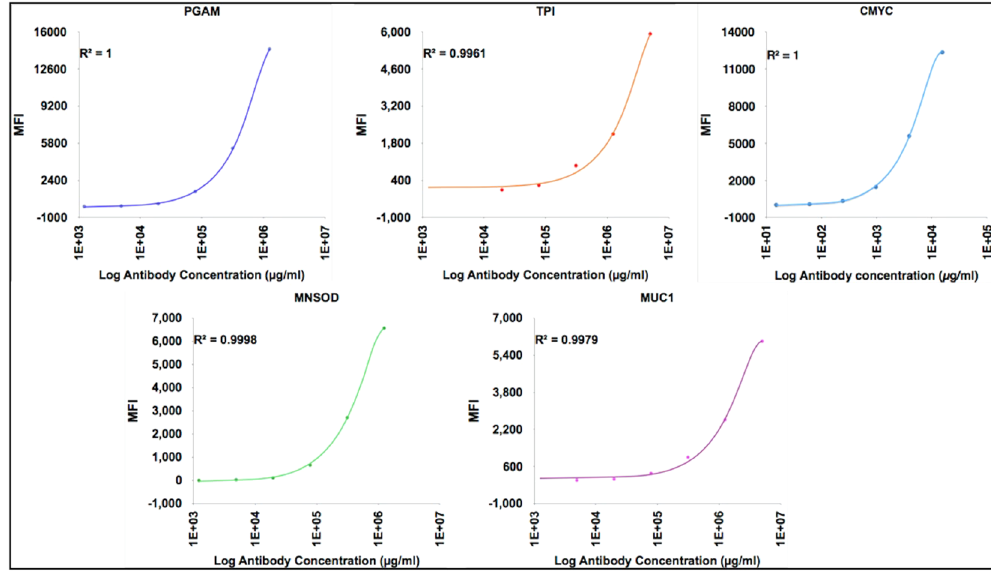
Figure 4. Validation of the coupling of MagPlex microspheres with the recombinant halotag fused TAAs. The protein coupled microspheres were reacted individually with increasing dilution of corresponding protein specific antibodies. The MFI signals generated by individual protein coupled microspheres increased with increasing concentration of antibodies in concentration dependent